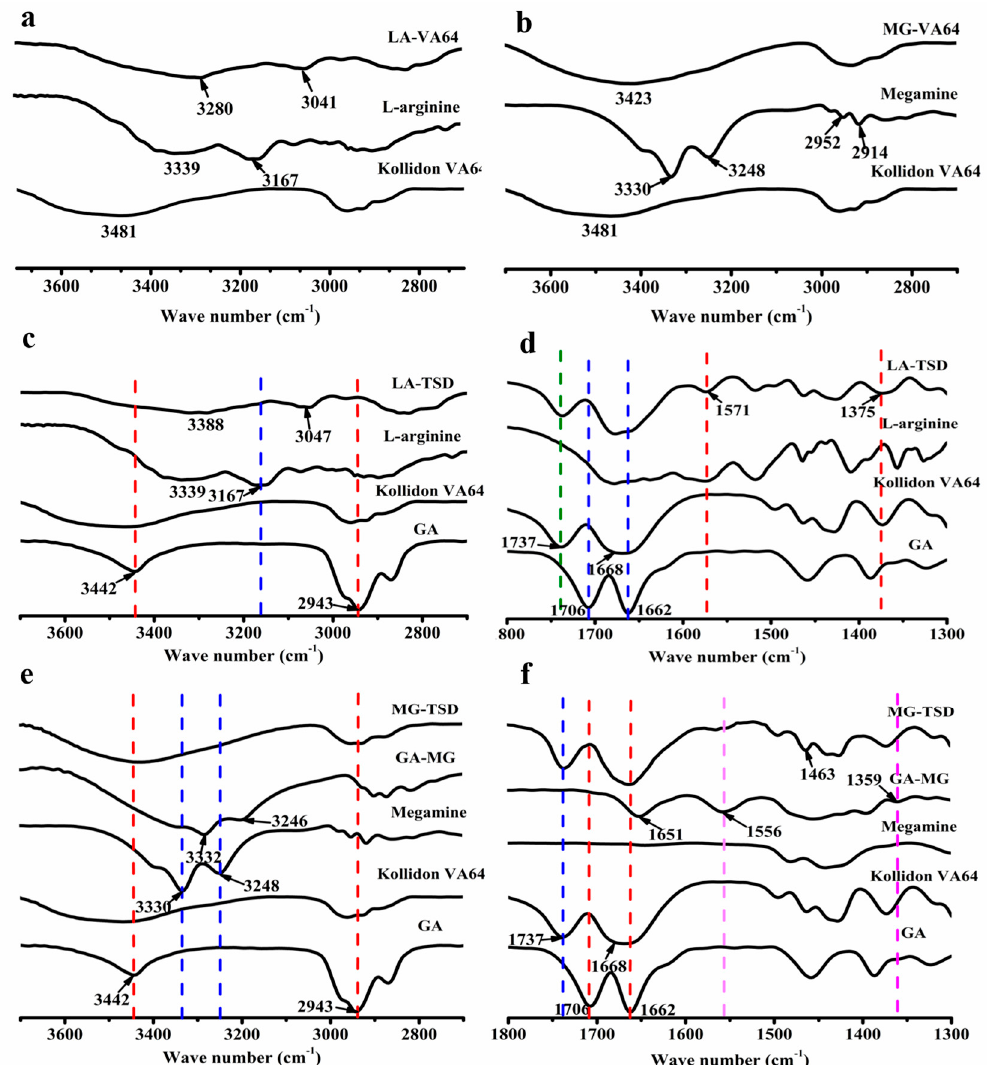
Figure 8. FT-IR spectra of GA, Kollidon ® VA64, and their SDs with and without alkalizers in a specific wavenumber range. ( a ) FT-IR spectra of Kollidon ® VA64, L-arginine and their extrudate in wavenumber range of 3700–2700. ( b ) FT-IR spectra of Kollidon ® VA64, meglumine and their extrudate in wavenumber range of 3700–2700. ( c ) FT-IR spectra of GA, Kollidon ® VA64, L-arginine and LA-TSD in wavenumber range of 3700–2700. ( d ) FT-IR spectra of GA, Kollidon ® VA64, L-arginine and